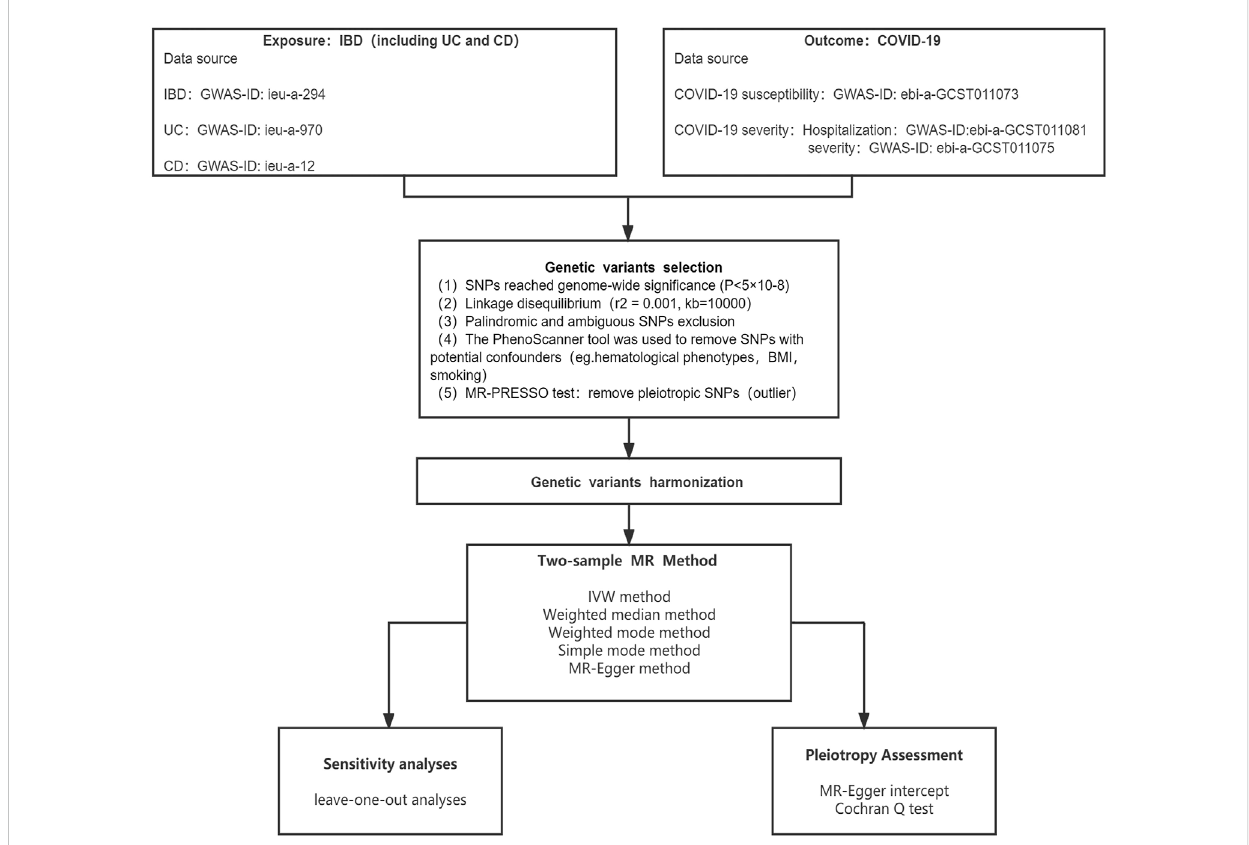
FIGURE 1 The Mendelian randomization (MR) analysis pipeline of the current